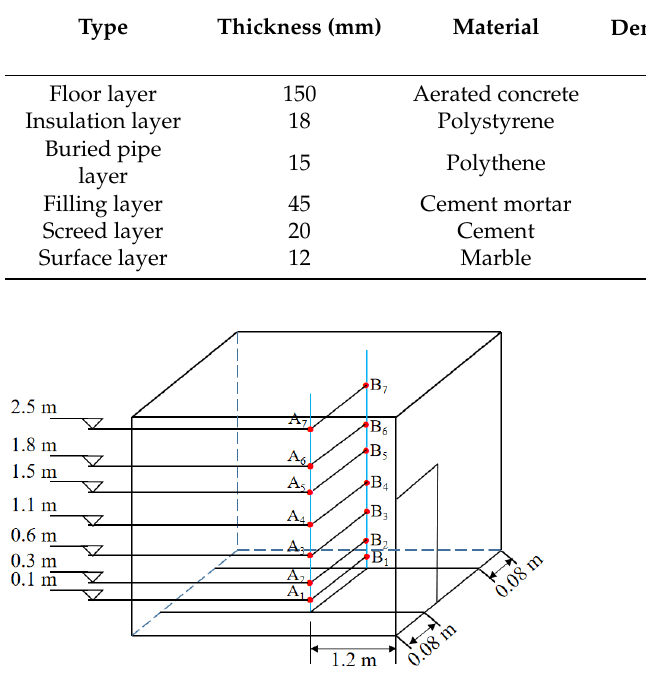
Figure 3. Location of the indoor measuring points. Table 2. Thermal parameters of the radiant